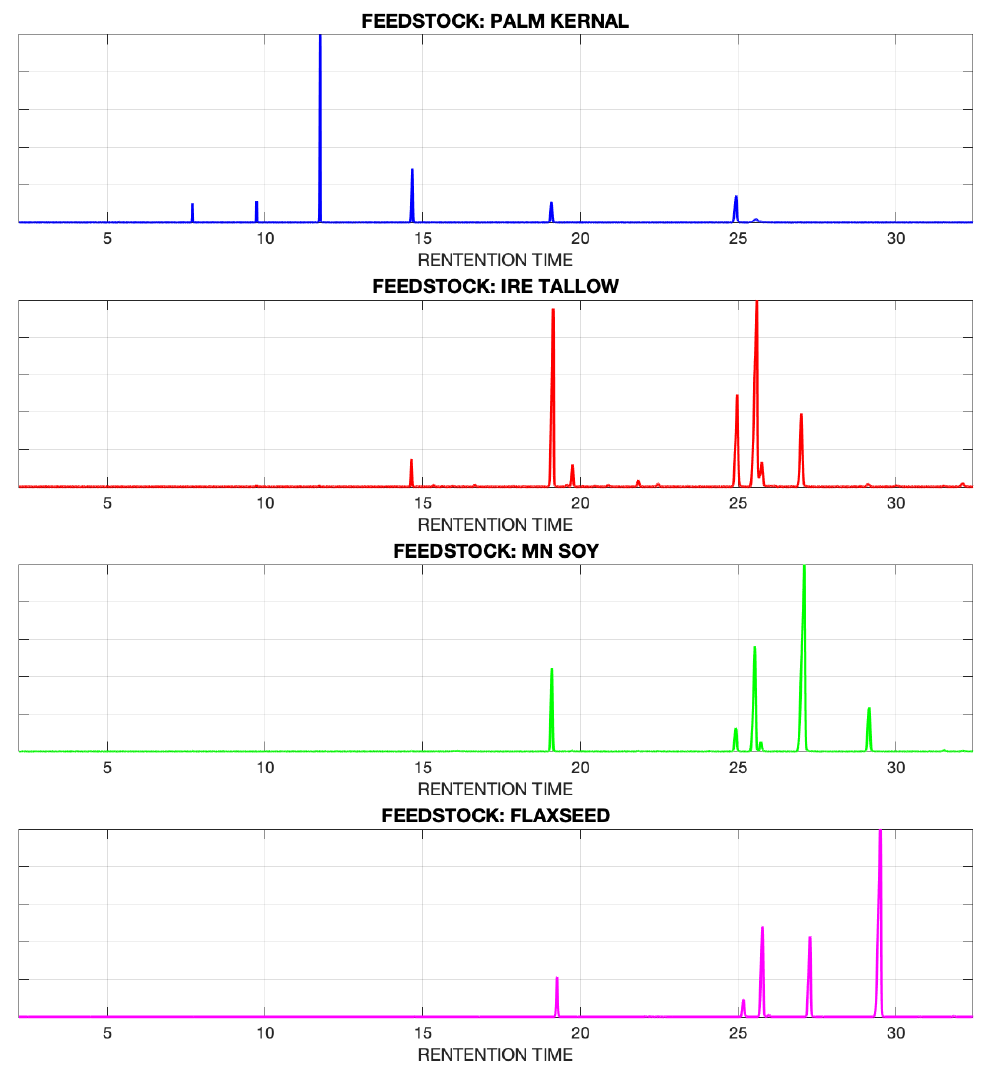
Figure 2. Stacked chromatograms of a B100 biodiesel for various feedstock types using ZB-FFAP (traditional, longer column). Each chromatogram has been normalized to its maximum value for